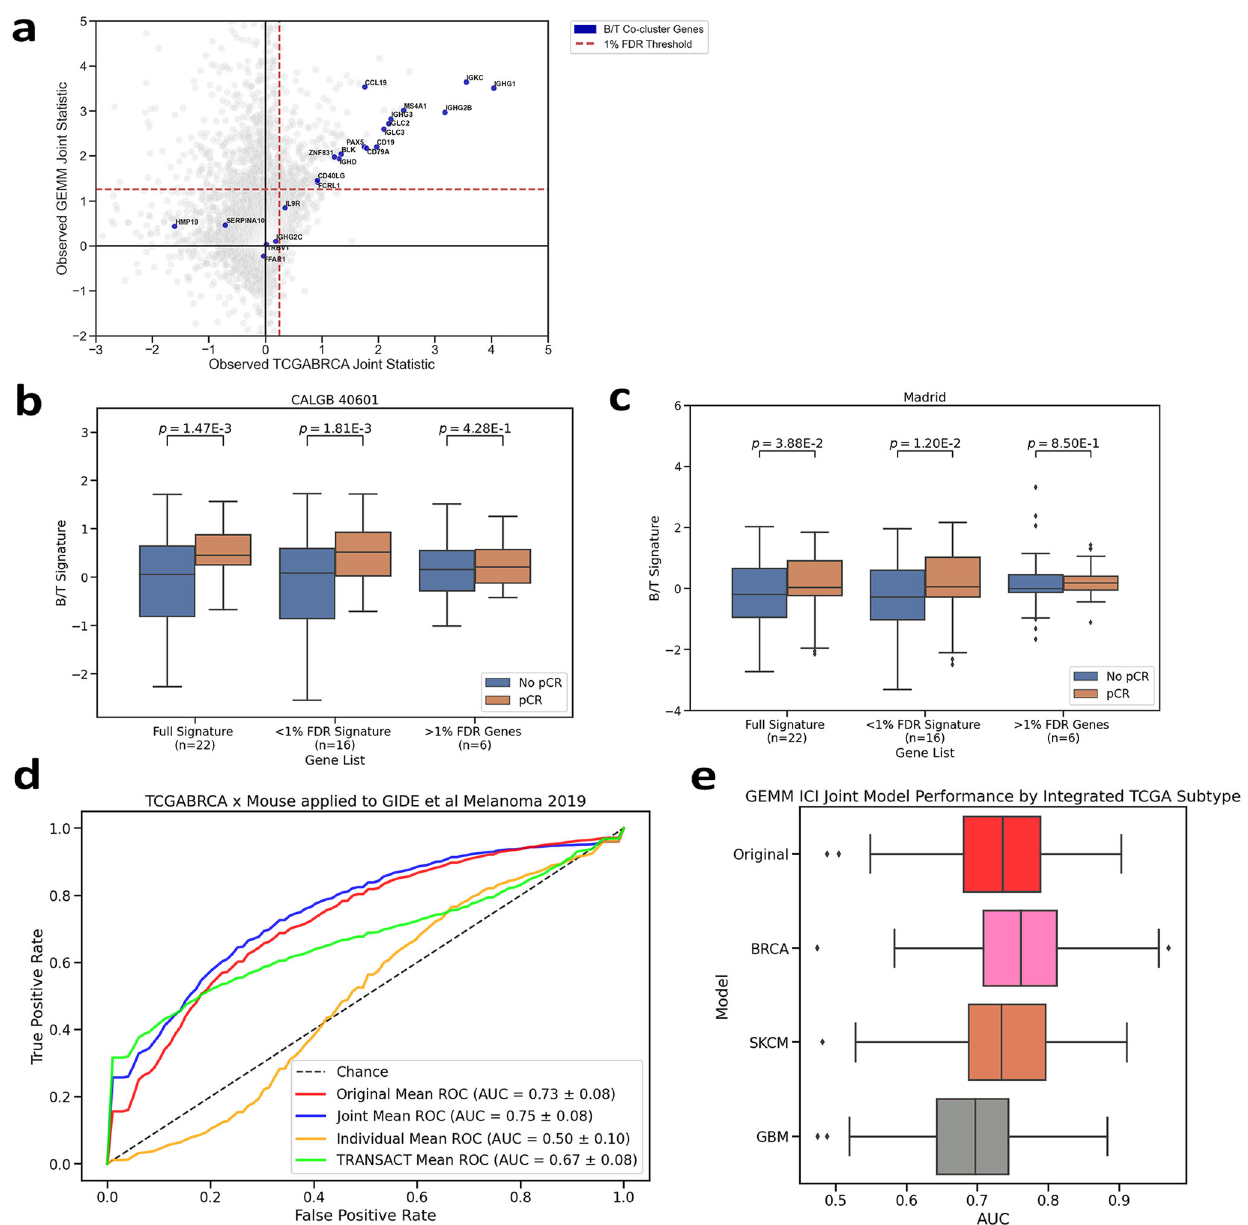
Fig. 5 Integrating GEMMs data with TCGA-BRCA. a Scatterplot of joint statistics of each gene in mouse and TCGA-BRCA joint datasets. Genes involved in the B cell/T cell co-cluster signature described in ref. 19 are highlights. Red dashed line indicates 1% FDR threshold of signi fi cant joint behavior. b , c Boxplots of B cell/T cell signature using all genes, signi fi cant joint genes, or fi ltered genes, applied to CALGB 40601, trastuzumab arm 28 and pretreatment samples from the TNBC MADRID NCT 011560663 clinical trial 27 – 29 . Signature was calculated as median expression of genes. Both datasets split by pCR. Two-tailed p values calculated from standard T-tests as in ref. 19 . d Receiver operating characteristic (ROC) curve of